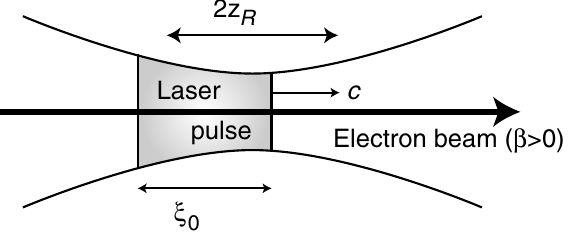
FIG. 4. Geometry of the electron beam and laser beam in the interaction